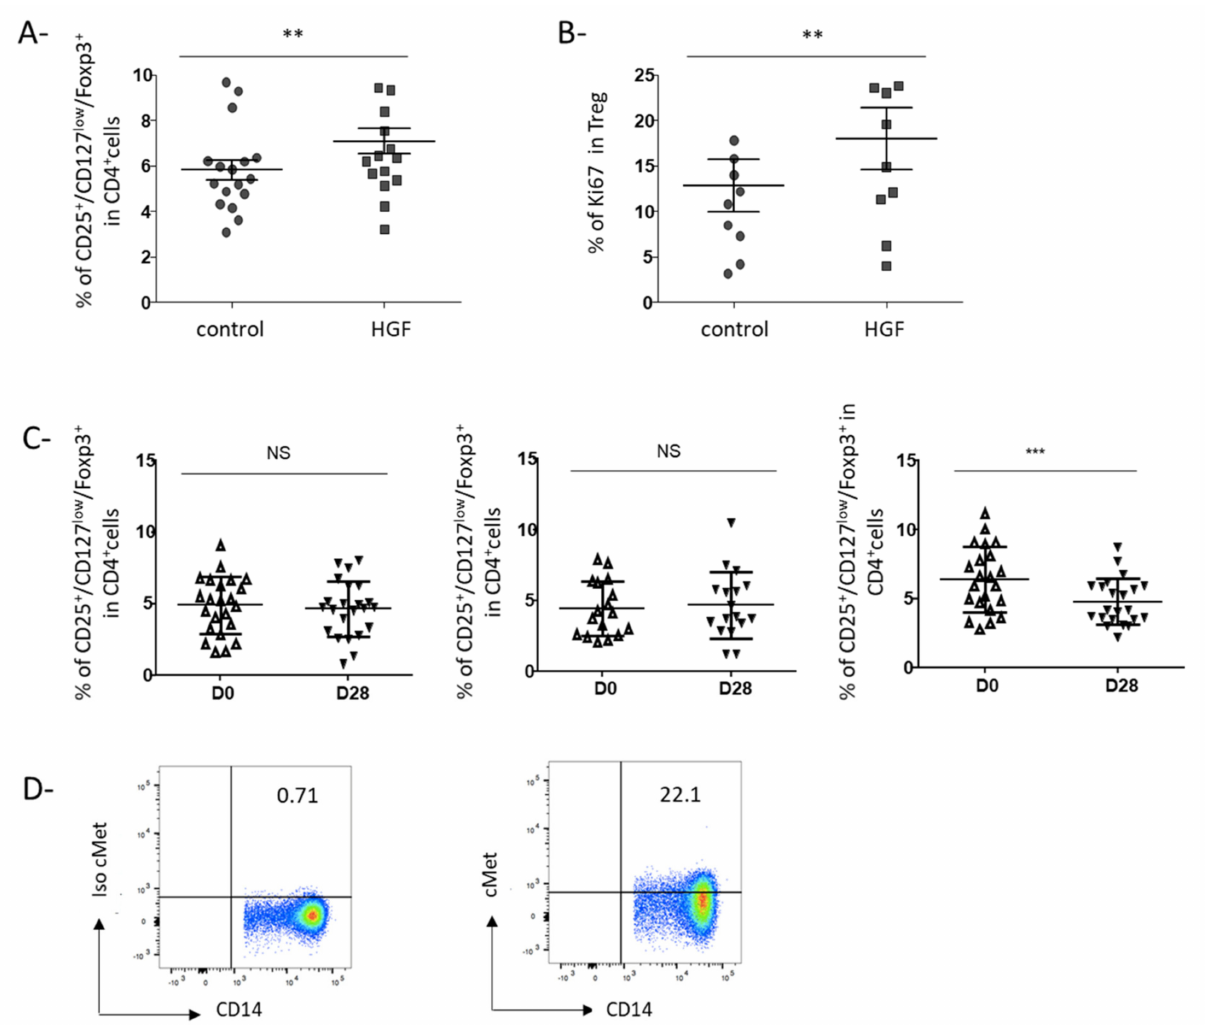
Figure 4. The proportion of regulatory T cells is enhanced by HGF-DCs in vitro and is decreased by rilotumumab (a monoclonal antibody targeting HGF) in vivo in gastric cancer patients. ( A , B ) After 6 days of culture, HGF-DCs or control- DCs were then co-cultured with freshly isolated CD4+ T cells from HC. After 7 days of co-culture, cells were collected and their phenotype was assessed by immunostaining and flow cytometry. Treg were defined as CD4 + CD25 + Foxp3 + CD127 low cells. Treg proliferation was assessed by Ki-67 intra-cellular expression. ( A ) The proportion of Treg amongst CD4 + T cells after 7 days of co-culture with control-DCs or HGF-DCs is shown ( n = 17). ( B ) Ki67 was assessed in Treg cells after 7 days of co-culture with control-DCs or HGF-DCs ( n = 10). ** indicates a p -value ≤ 0.01 according to the Wilcoxon test. ( C , D ) The PRODIGE 17-ACCORD 20-MEGA trial is a randomized three-arm phase II study that evaluated the efficacy of 3 treatment regimens in patients with advanced GC: chemotherapy (FOLFOX) alone, an association of FOLFOX + panitumumab (an anti-EGFR monoclonal antibody), or association of FOLFOX + rilotumumab (an anti-HGF monoclonal antibody). PBMCs were collected before (day 1) and after 2 cycles of treatment (day 28). Immunostaining was then performed and cells were analyzed by flow cytometry. Treg was defined as CD4 + CD25 + Foxp3 + CD127 low cells, monocytes were defined as CD3 − /CD56 − /CD19 − /CD14 + /HLA-DR + cells as previously described. ( C ) Proportions of Treg amongst circulating CD4 + cells before and after two cycles of treatment in GC patients treated with FOLFOX ( n = 23, left panel), FOLFOX + anti EGFR ( n = 17, middle panel) or FOLFOX + anti HGF ( n = 21, right panel) are shown. *** indicates a p -value ≤ 0.005 according to the Wilcoxon test. ( D ) Monocytes from PBMC of 9 GC patients included in the PRODIGE17-ACCORD20-MEGA trial were stained as described in Figure 1 ( n = 9). Representative staining out of 9 independent experiments is shown. Results are indicated as percentages of c-Met positive